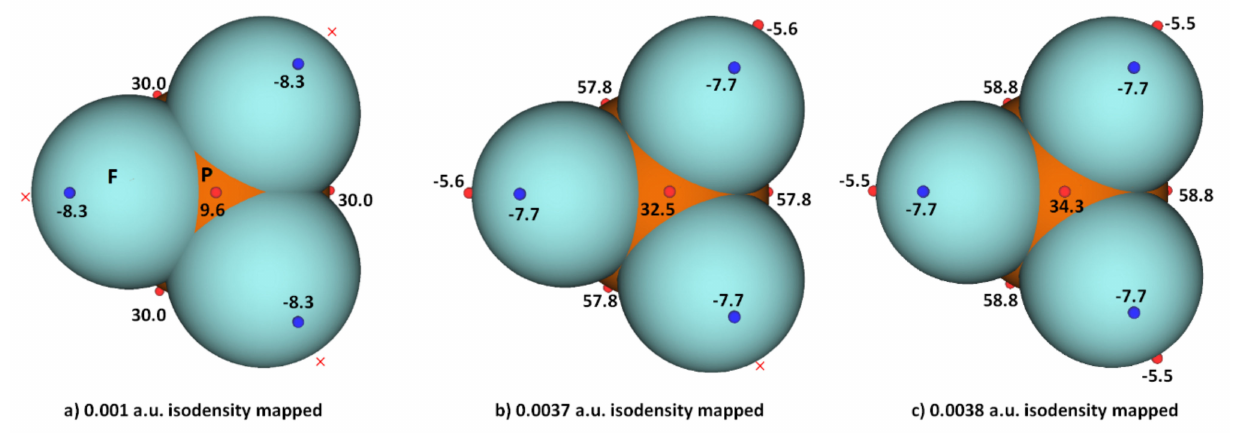
Figure 4. Comparison of ω B97XD/Jorge-ATZP level computed local maxima and minima of elec- trostatic potential of PF 3 mapped on three different isoelectron density surfaces (( a ) 0.001 a.u.; ( b ) 0.0037 a.u.; ( c ) 0.0038 a.u.), showing the dependence of V S,max and V S,min on the value of isoden- sity envelope used. The red crosses indicate the missing maxima on covalently bonded F. The tiny circles in red and blue represent the V S,max and V S,min , respectively. Values in kcal mol − 1